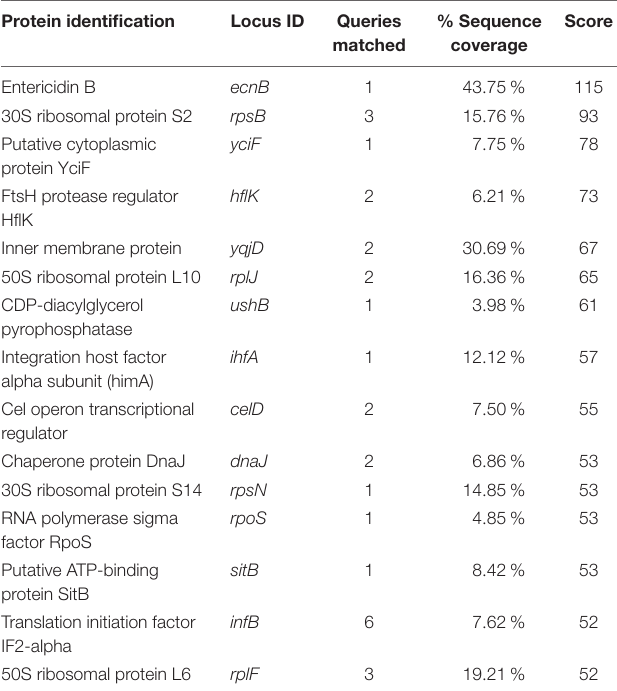
TABLE 3 | Binding proteins identified in S. sv. Typhimurium after cross-linking with App bound to a glass bead. Protein